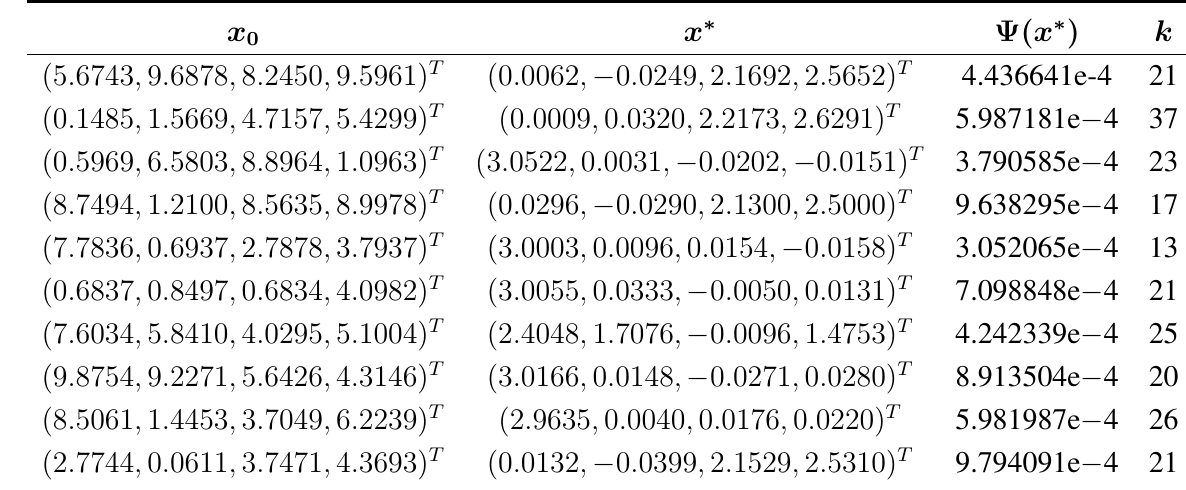
Table 4. Number of iterations and the final value of Ψ( x ∗ )